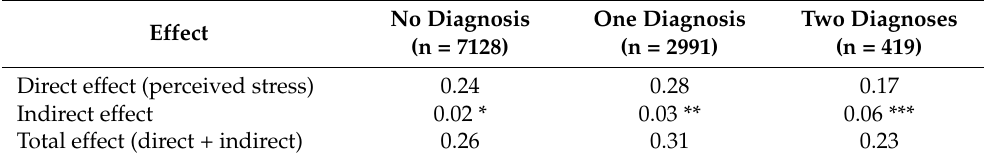
Table 4. The strength of the relationships between variables due to direct, indirect and total structural effects of perceived stress, sedentary behaviour, daily physical activity, physical exercise, and dietary habits on self-rated